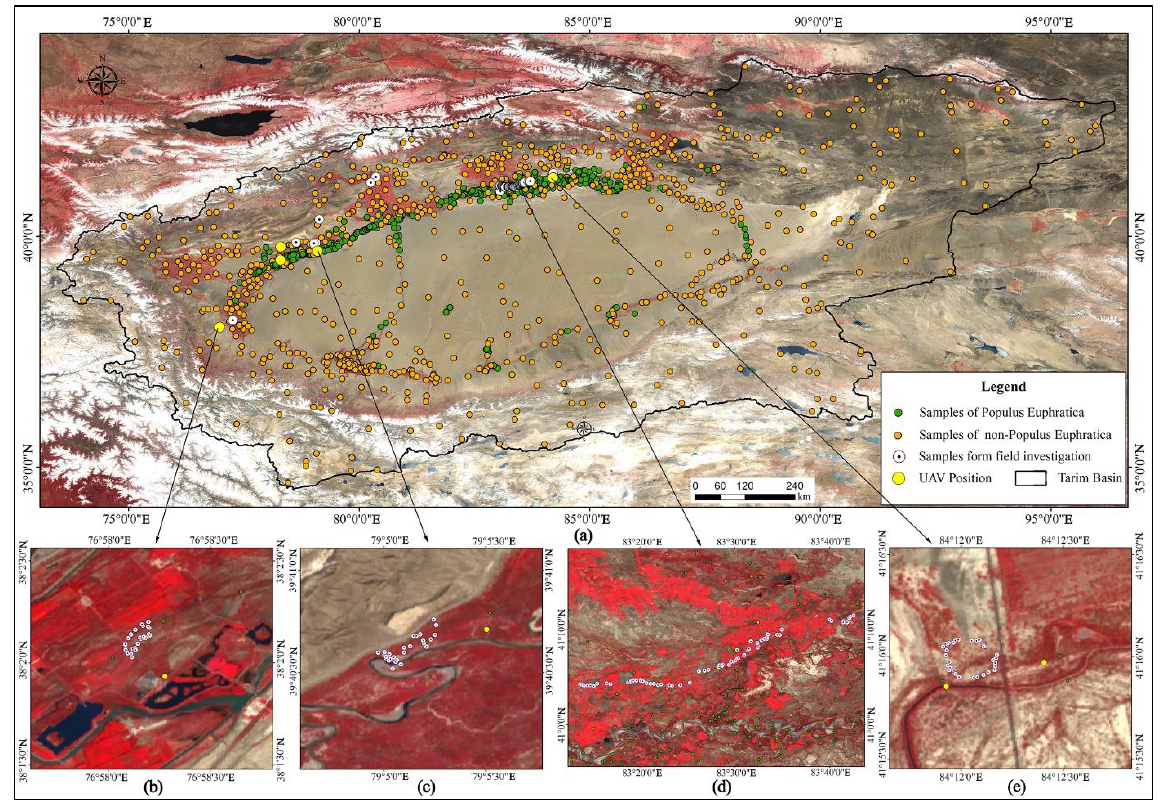
Figure 7. Distribution map for validation samples. ( a ) Validation samples in the study area; ( b ) field-surveyed samples in Zepu; ( c ) field-surveyed samples along the Yarkant River riparian zone; ( d ) field-surveyed samples in Shaya; ( e ) field-surveyed samples in Tarim Park.